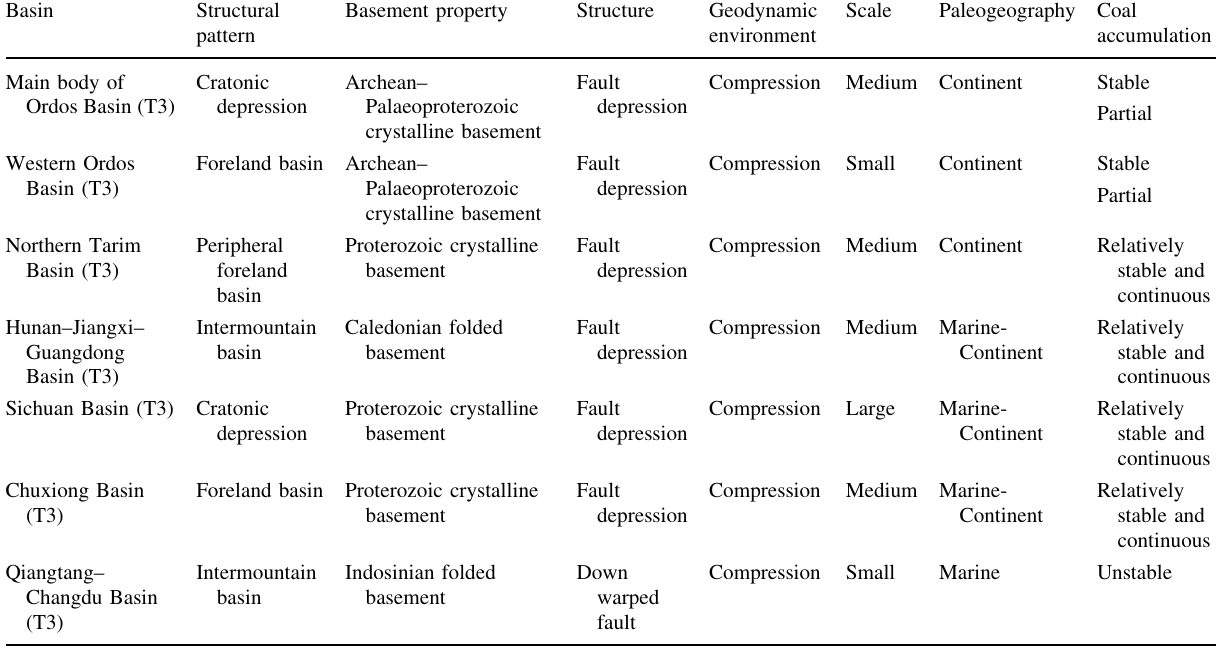
Table 4 Comprehensive types of coal-forming basins in the Late